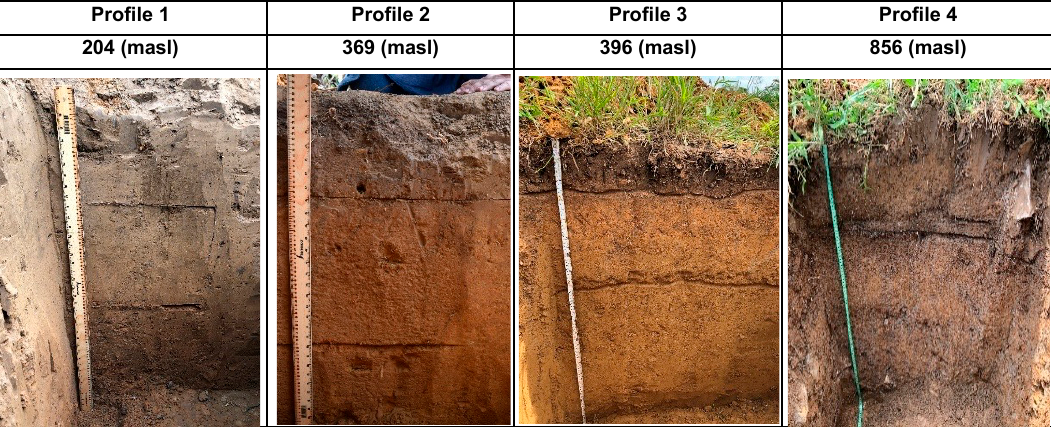
Figure 3. Detailed photographs of the analyzed soil profiles in Piedmonte Llanero of Colombia. Table 3. Main soil chemical, physical, and physico-chemical properties in the Piedemonte Llanero of